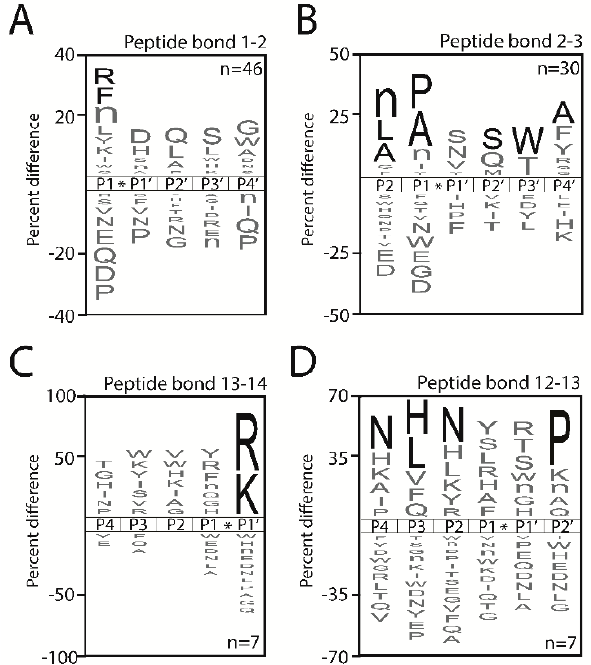
Figure 3. Substrate specificity pattern of pig plasma samples determined using multiplex substrate profiling by mass spectrometry. ( A – D ) The iceLogo plots represent amino acids that are most frequently above the axis and least frequently below the axis when observed in the cleavage sites [21]. The time at which the cleavage was observed is indicated at the top of each plot. Residues shown in black are significantly ( p < 0.05) increased in frequency while residues in gray have p > 0.05. Lowercase n corresponds to norleucine while the number of cleavage sites used to make the iceLogo plots are indicated in the bottom right corner of each panel.